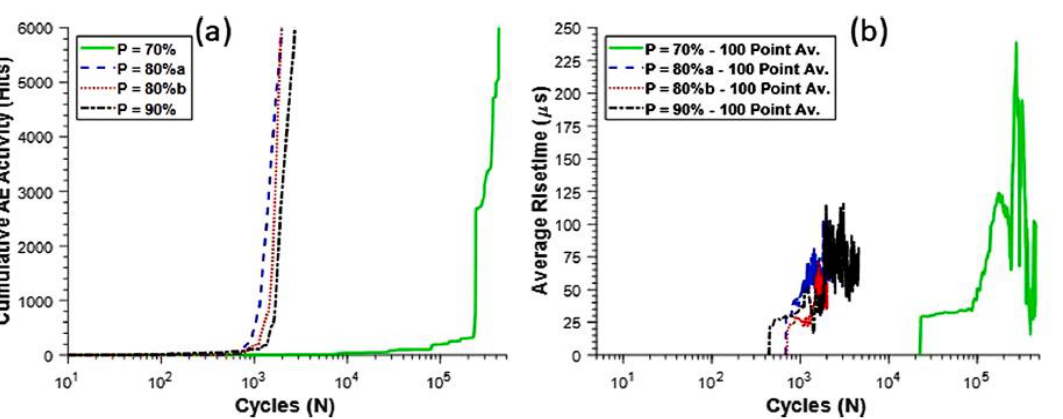
Figure 8. ( a ) Cumulative AE activity and ( b ) average risetime (100 point moving average) for all